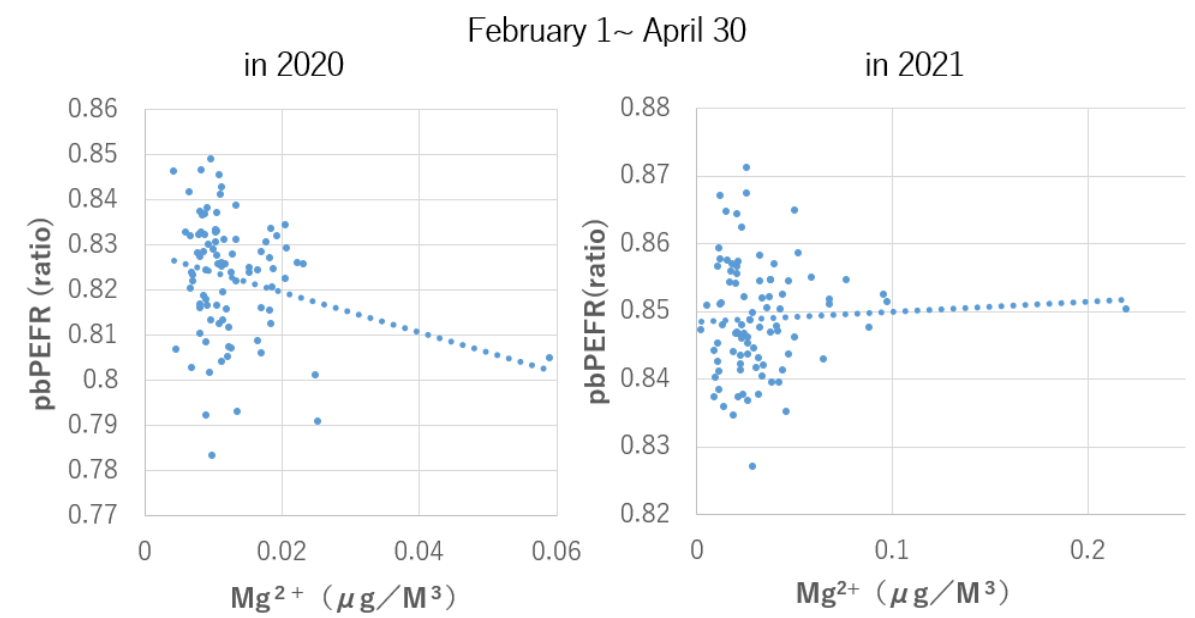
Figure 3. Relationship between daily Mg 2+ concentration and daily average of the ratio of peak expiratory flow rate to personal best peak expiratory flow rate on that day.